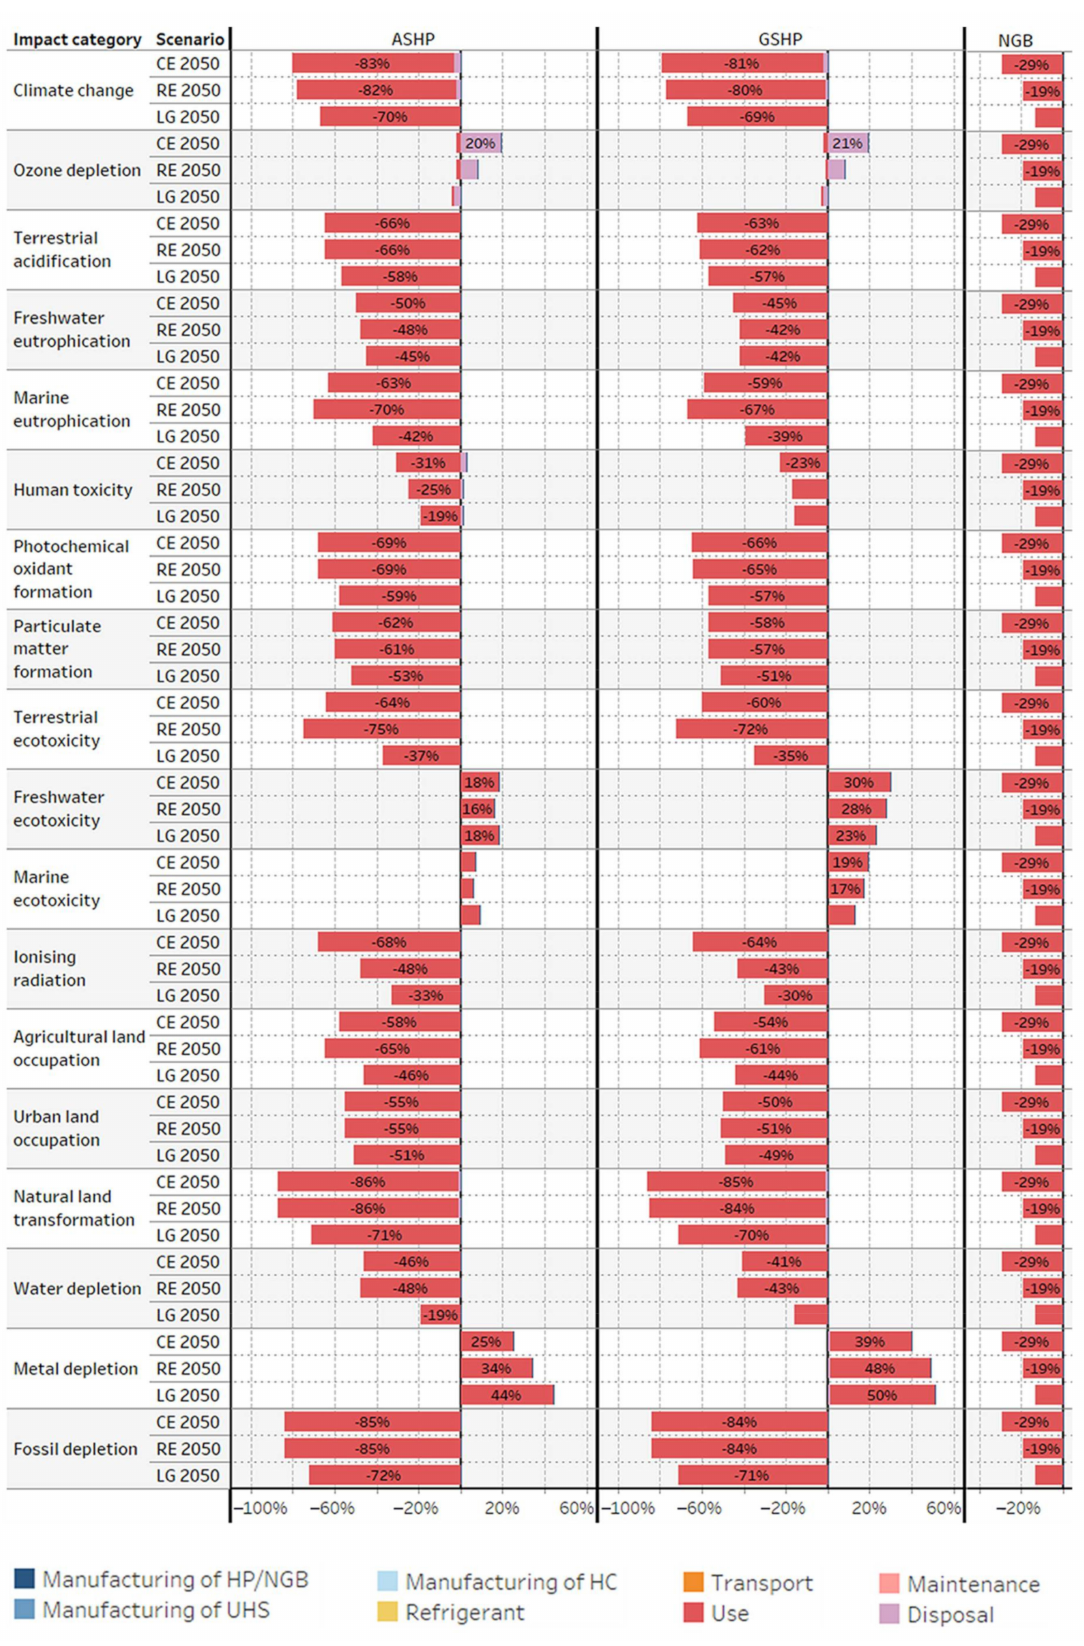
Figure 4. Lifecycle environmental impact change of phases in future